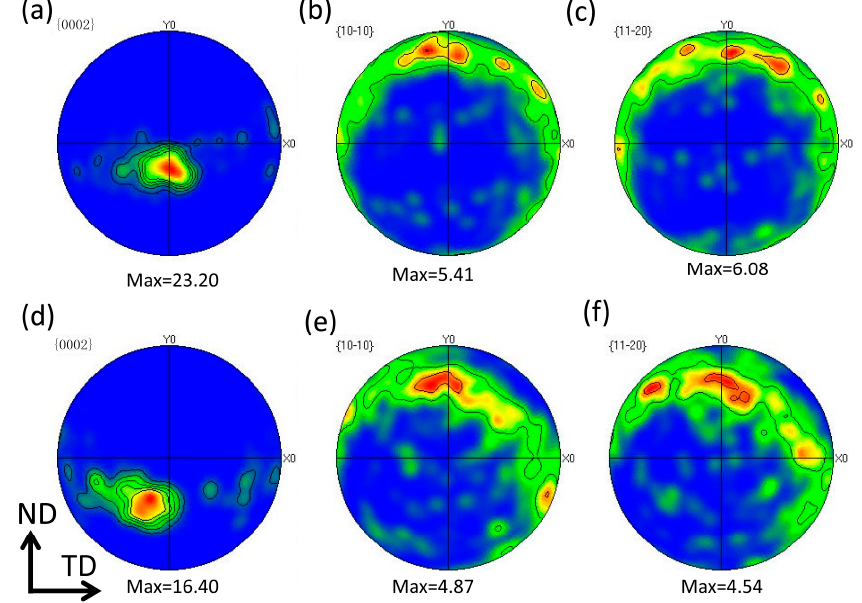
Figure 6. {0002}, {10-10} and {11-20} pole figures of a ( a – c ) one-pass and ( d – f ) two-pass FSP AZ61 alloys. ND: normal direction; TD: transverse direction.